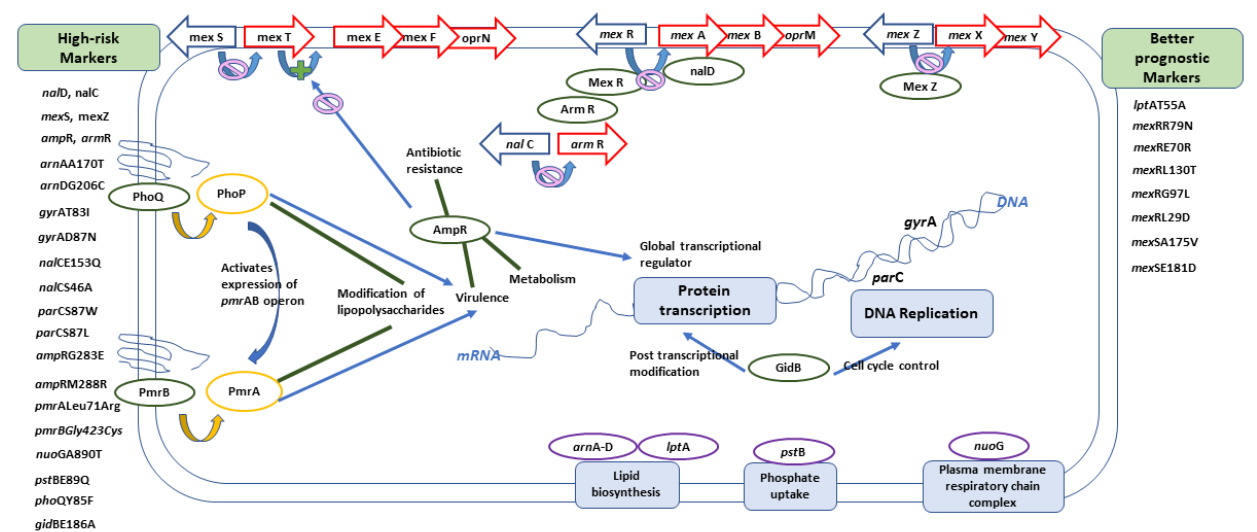
Figure 9. A graphical summary showing the role of different genes within the cell. Supplementary Materials: The following are available online at www.mdpi.com/xxx/s1, Table S1: Quinolones’ MIC values for the studied set of sequences and their corresponding STs and serotypes; Table S2: Aminoglycosides’ MIC values for the studied set of sequences and their corresponding STs and serotypes; Table S3: ID of studied set of sequences from the Patric database and their acces- sion numbers.